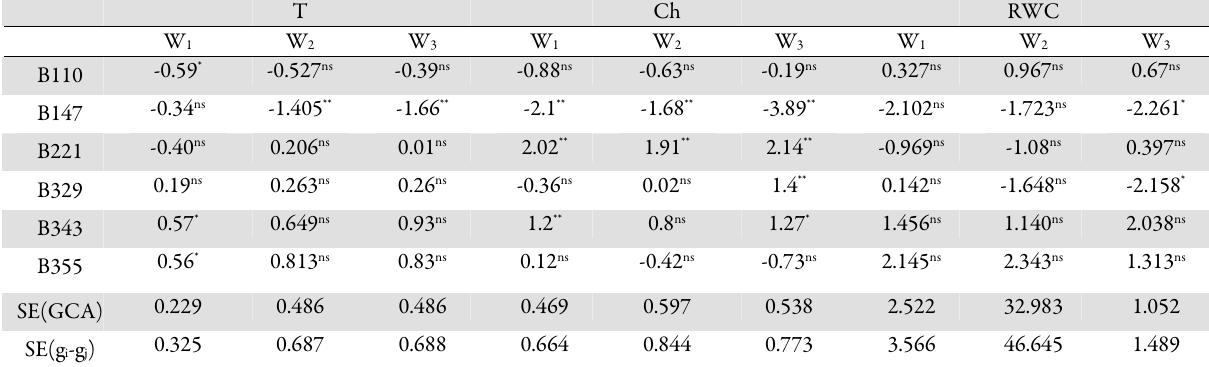
Tab. 3.1. Estimates of general combining ability of the female lines for canopy temperature (T), chlorophyll fluorescence (Fvm), chlorophyll content (Ch), relative water content (RWC) at the different levels of irrigation. Normal irrigation (W 1 ), mild water stress (W ), severe water stress (W